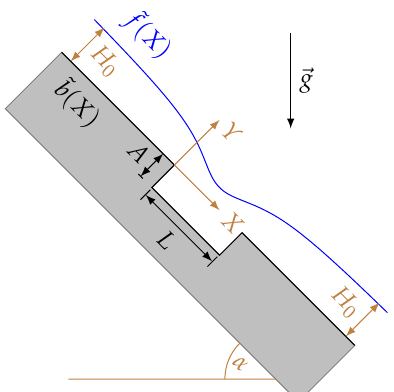
Figure 1. Schematic of a continuous film of liquid, asymptotic thickness H 0 , flowing down a rigid piece-wise planar substrate, ˜ b ( X ) , inclined at angle α to the horizontal and containing, for illustration purposes, a sharp trench topography, height A and length L ; shown also is the orientation of the corresponding ( X , Y ) co-ordinate system, with ˜ f ( X ) denoting the shape of the free surface disturbance experienced by the